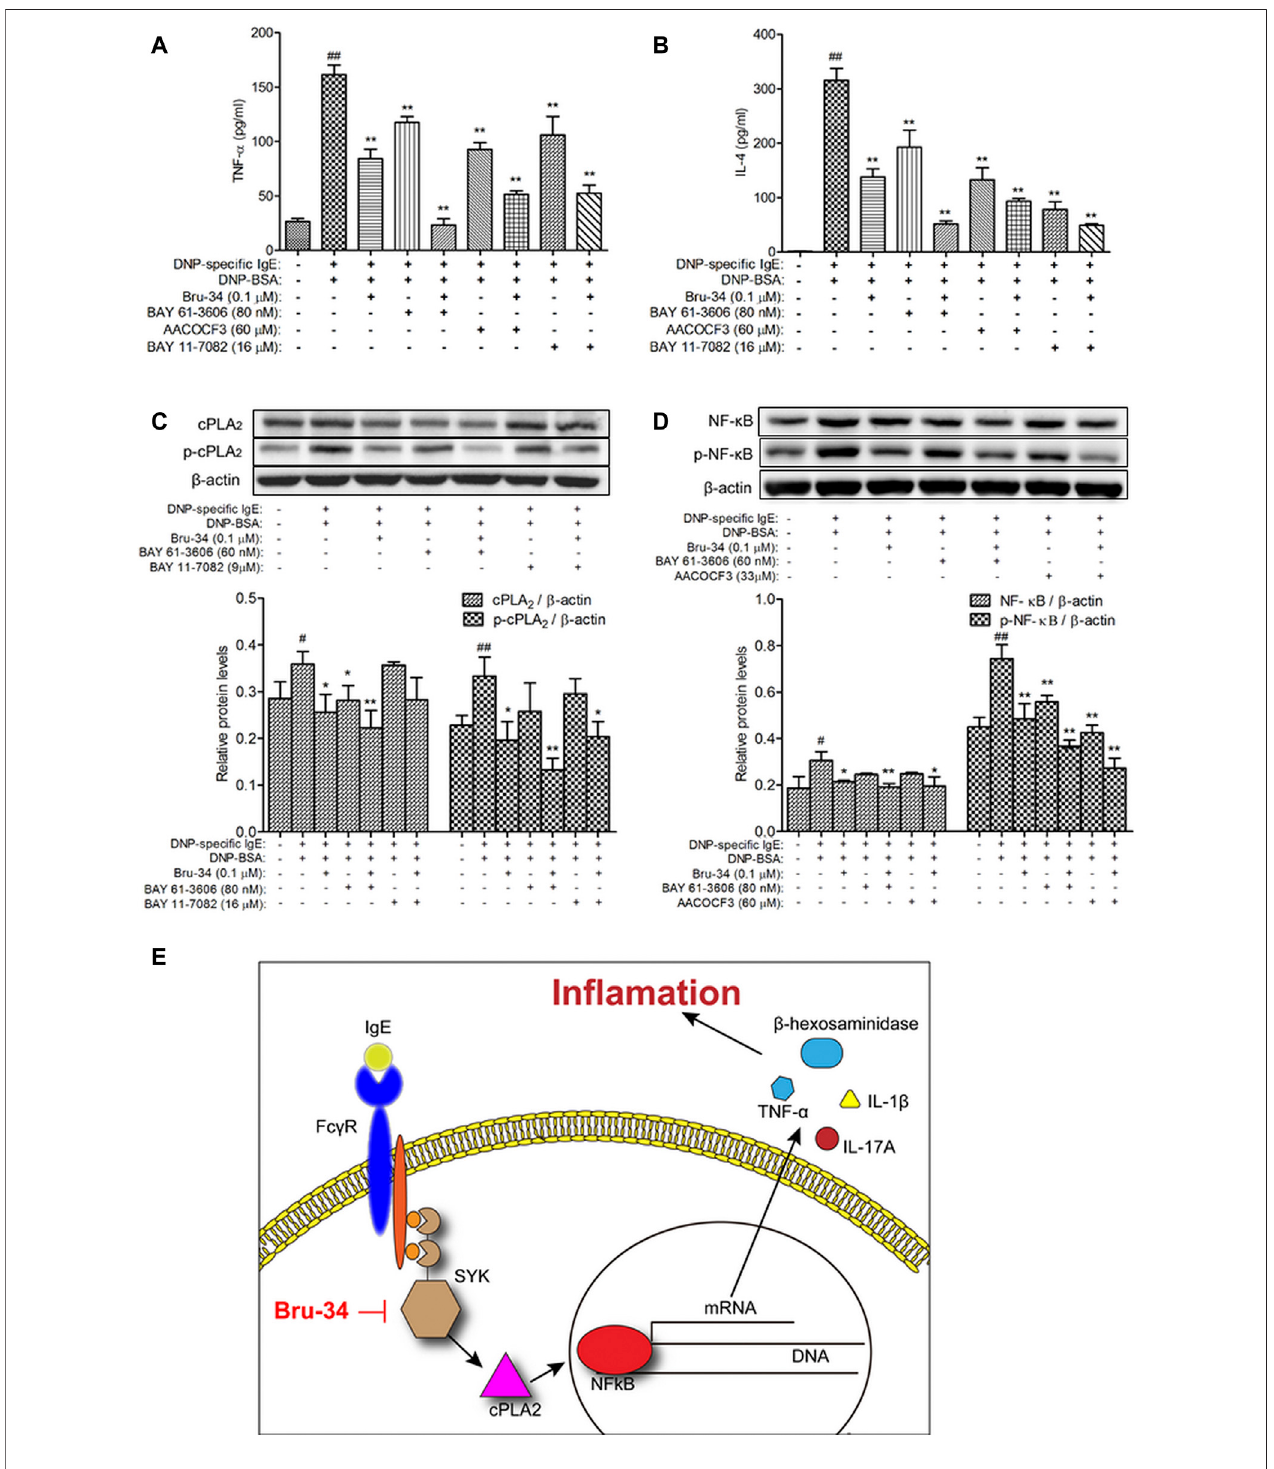
FIGURE 7 | Veri fi cation that Syk, cPLA2 and NF- κ B were associated with Bru-34attenuated IgE-induced In fl ammation in vitro . Panel (A) : The concentrations of TNF- α in the supernatants were quanti fi ed by ELISA ( n (cid:2) 8); Panel (B) : The concentrations ofIL-4 in the supernatants were quanti fi ed by ELISA ( n (cid:2) 8); Panel (C) : Cell lysates fromSyk and NF- κ B inhibitors treated cells were collected, cPLA2 and p-cPLA2 wereanalyzed by Western blotting ( n (cid:2) 3); Panel (D) : Cell lysates from Syk and cPLA2inhibitors treated cells were collected, NF- κ B and p-NF- κ B were analyzed by Westernblotting ( n (cid:2) 3); BAY 61-3606: syk inhibitor, AACOCF3: cPLA2 inhibitor, BAY11-7082: NF- κ B inhibitor; Data were given as mean ± S.D.; Panel (E) : Schematicillustrating the mechanism by which Bru-34 Attenuates Allergic Airway In fl ammationvia Inhibition of the Syk Pathway.